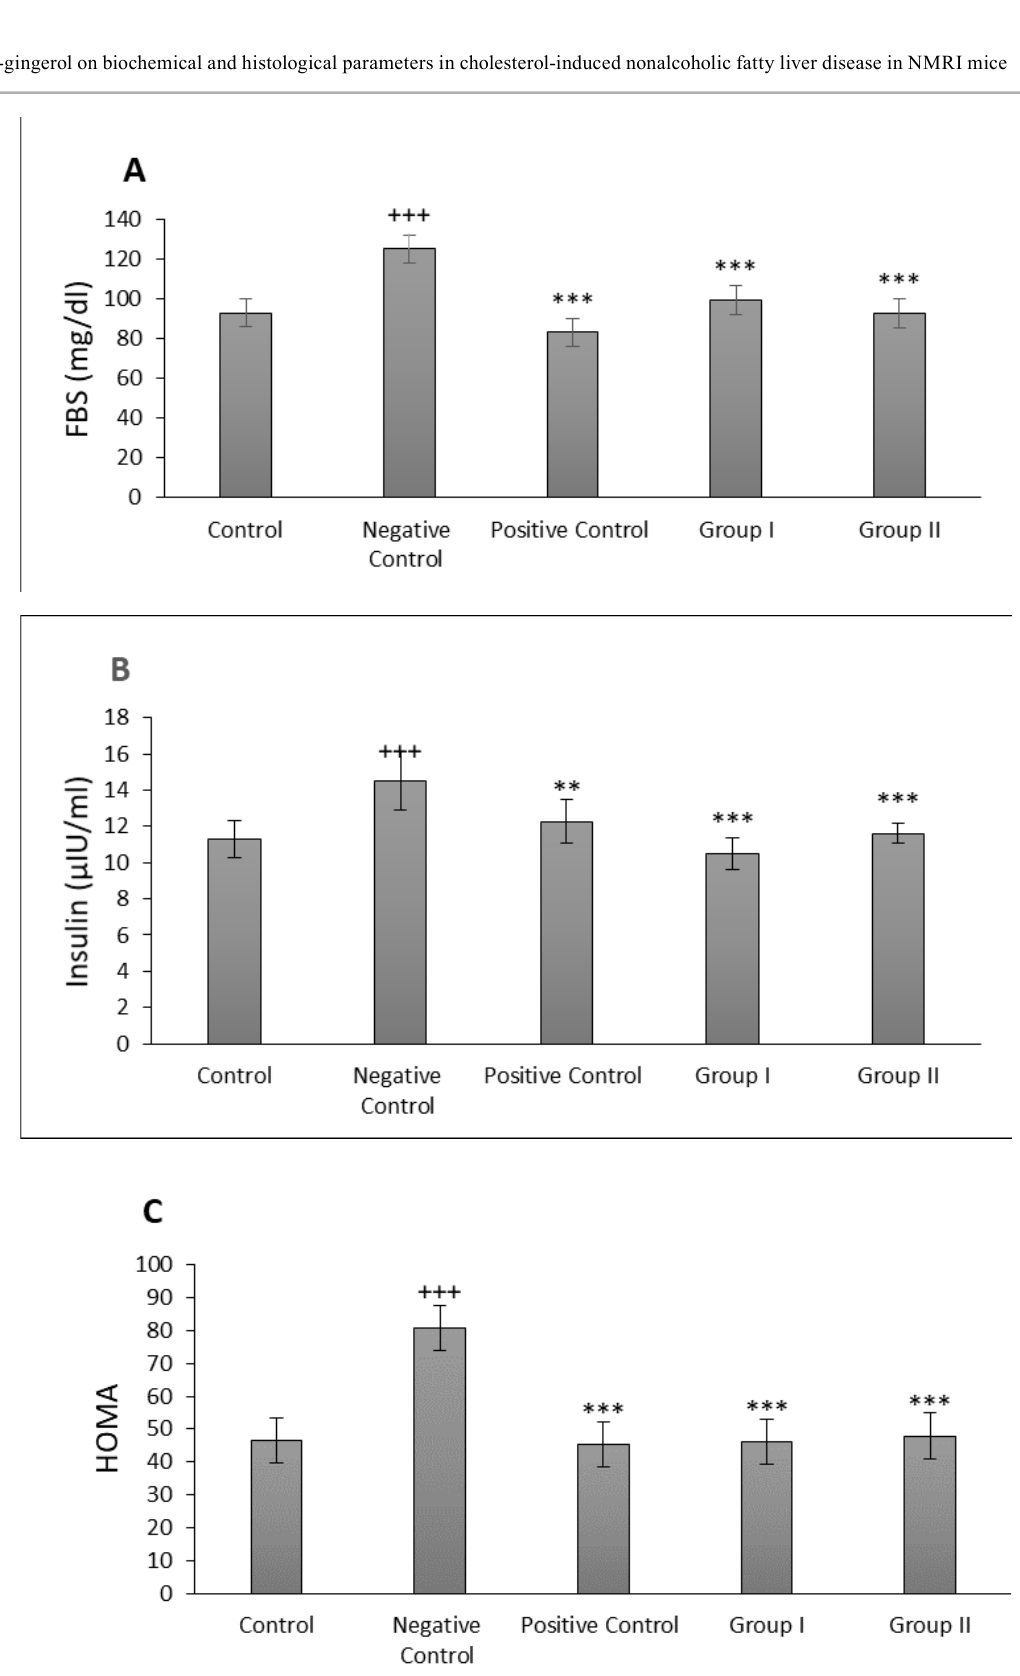
FIGURE 1 – C hanges in the levels of fasting blood glucose (A), insulin (B), and insulin resistance (HOMA) (C) affected by 6-gingerol in fatty liver-induced mice. Values are reported as mean ± SD. +++ p <0.001 as compared with the control group; ** p <0.01 and *** p <0.001 as compared with the negative control